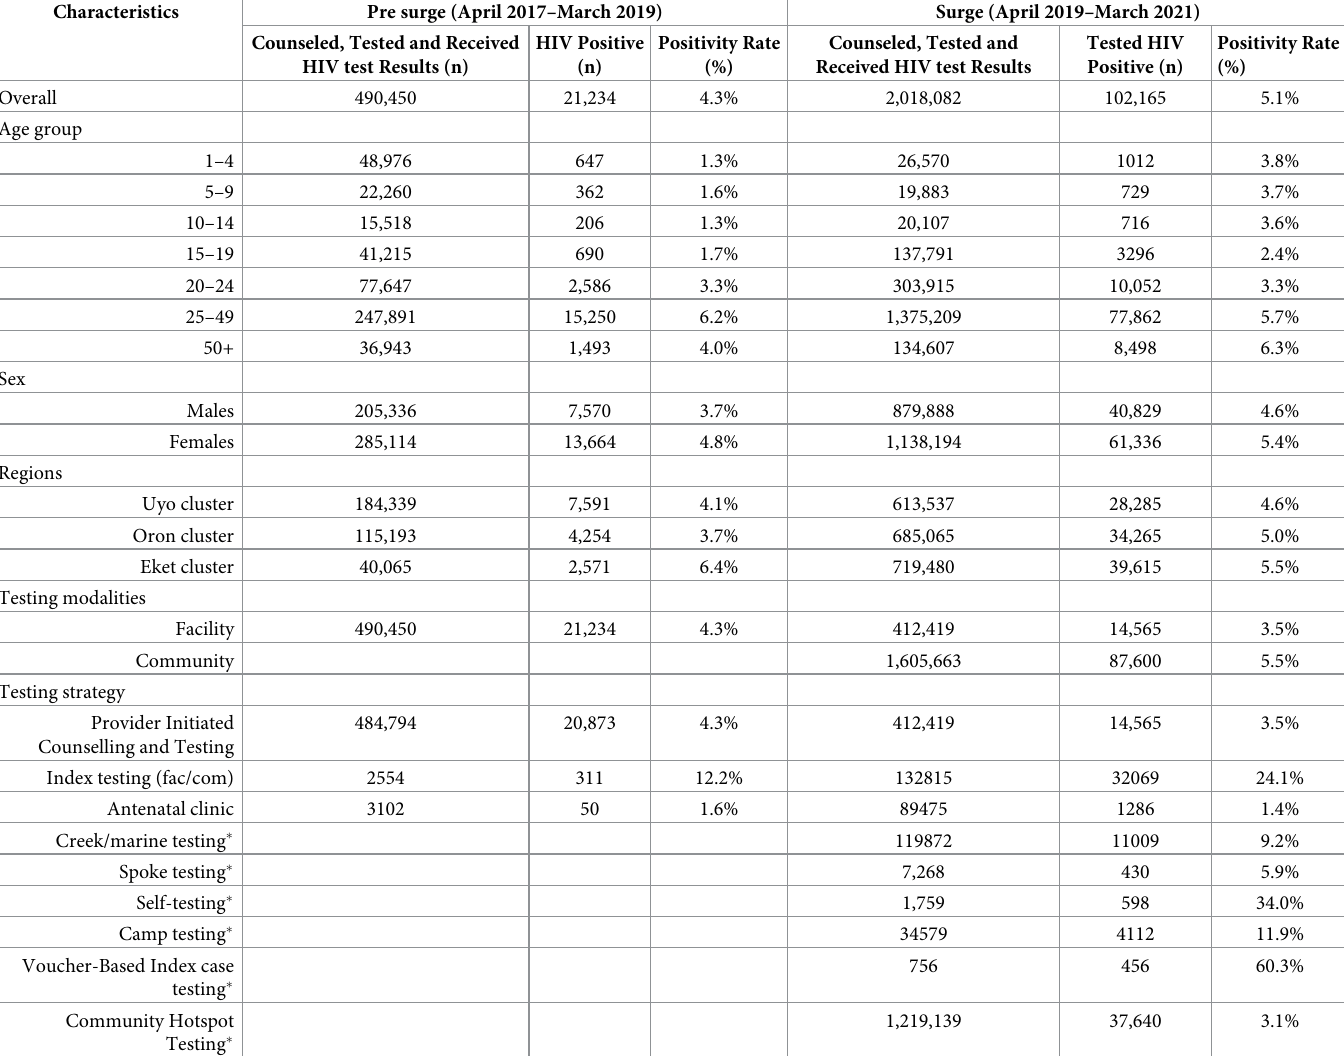
Table 3. Pre-surge and surge HIV case finding April 2017 to March 2021, Akwa Ibom State, Nigeria.